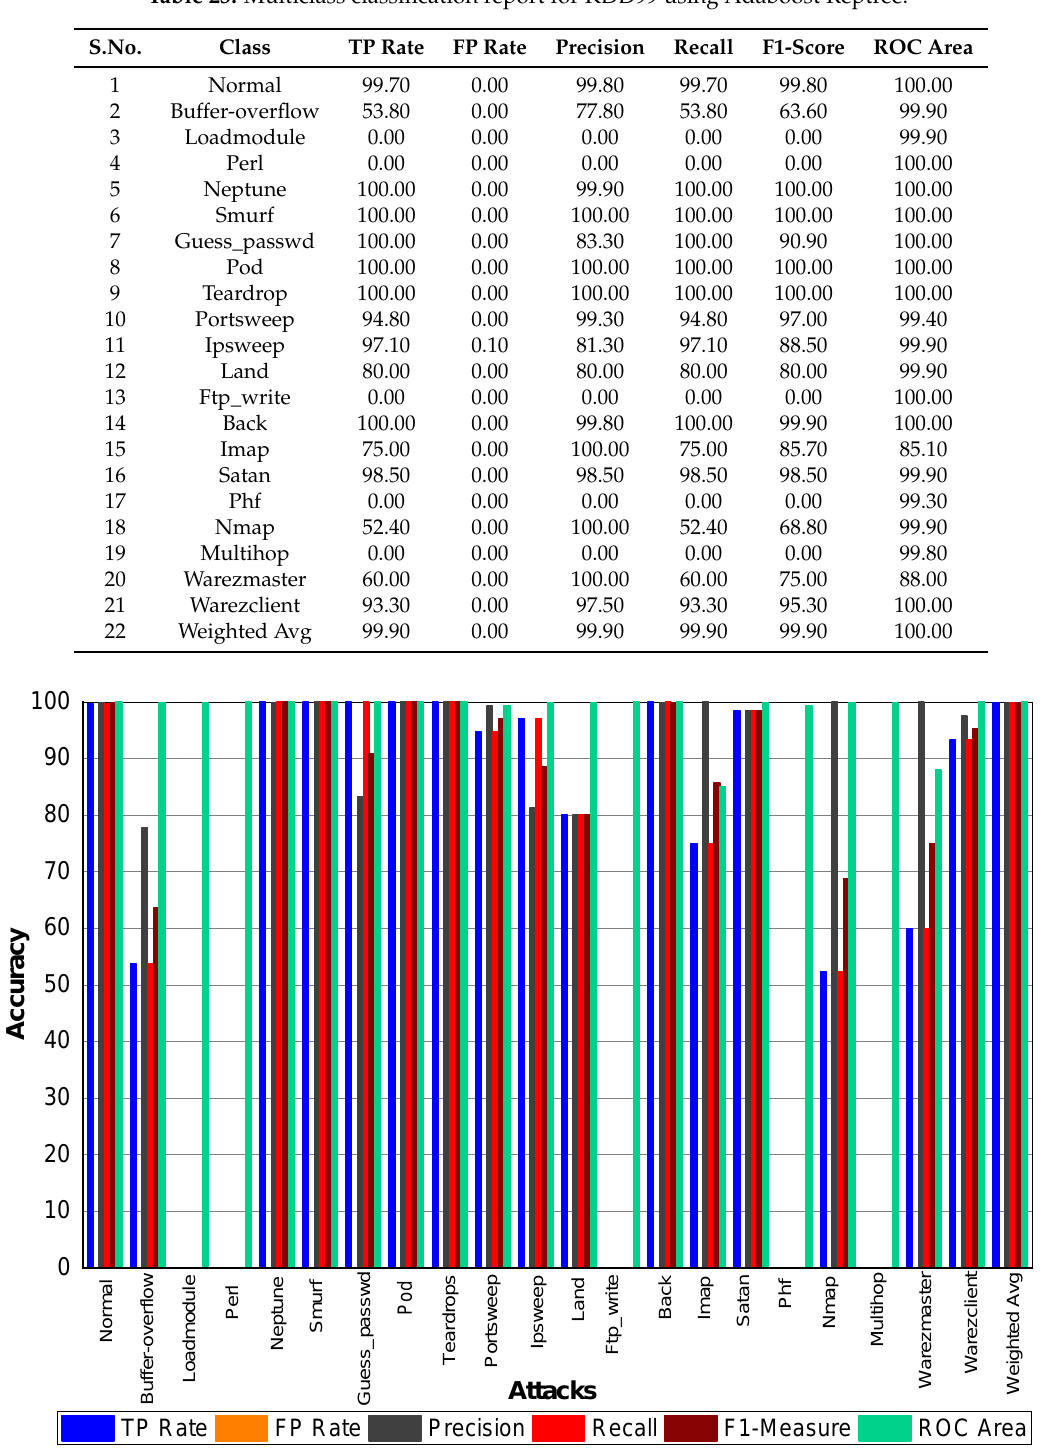
Table 23. Multiclass classification report for KDD99 using Adaboost Reptree.